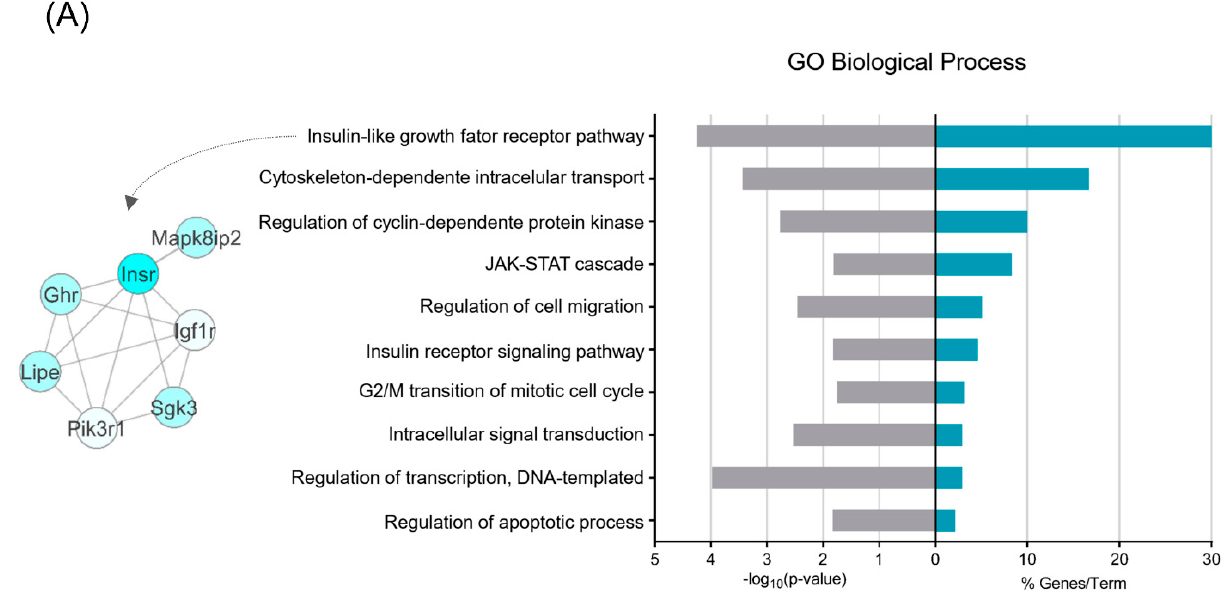
Figure 5. miR-497-5p target genes enrich the insulin-growth factor pathway. ( A ) Biological processes terms (GO) en- riched for miR-497-5p target genes ( p -value ≤ 1.82 x 10 -2 ). Insr , Igf1r , Pik3r1, and Mapk8ip2 mRNA levels in differentiated C2C12 myotubes transfected with miR-497-5p mimic ( B ) or inhibitor ( C ). ( D ) Insr and Ingf1r expression levels in differ- entiated C2C12 myotubes treated with IL-6 and control (PBS). RT-qPCR data are represented as fold change (2 −ΔΔ Ct ) rela- tive to Rpl13a . Data represent the average of three independent experiments with standard deviation. Statistical differ- ence was analyzed by Student’s t -test. Insr : insulin receptor; Igf1r : insulin-like growth factor 1 receptor; Pik3r1 : phospho- inositide-3-kinase regulatory subunit 1; Mapk8ip2 : mitogen-activated protein kinase 8 interacting protein 2.